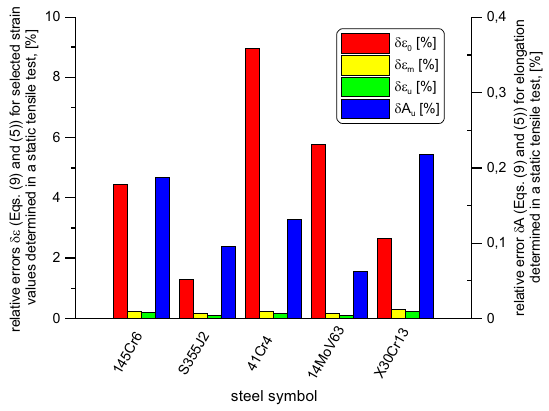
Figure 12: Comparison of the relative errors δε and Δ A for selected strain and elongation values determined in the static tensile test using equations ( 9 ) and ( 5 ) .